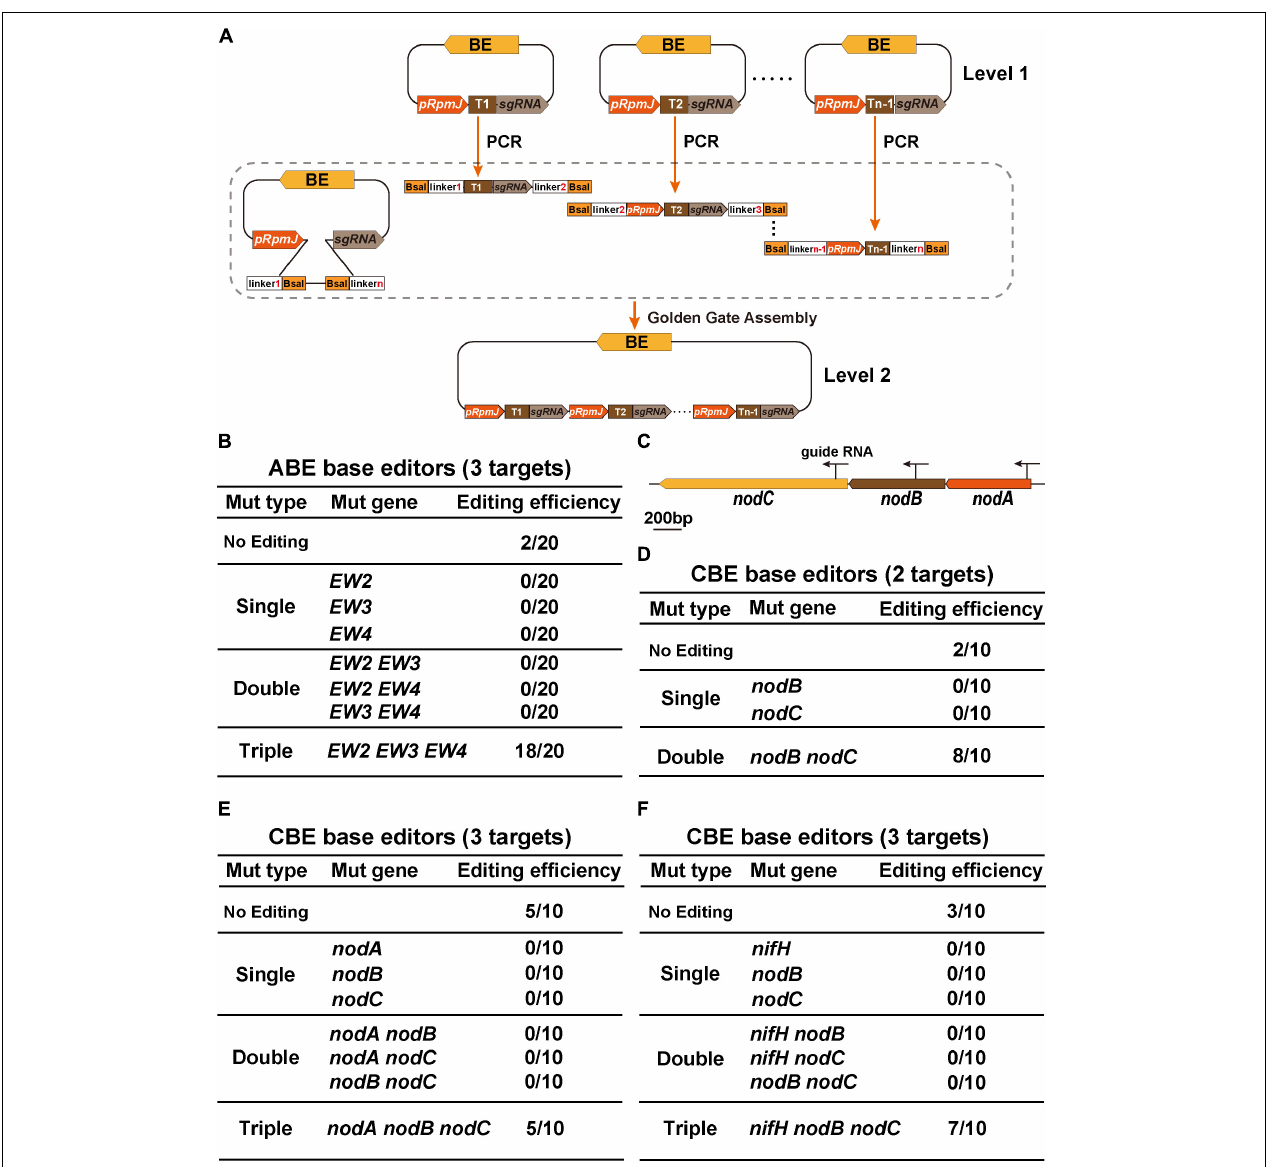
FIGURE 4 | GGA-based multiplex gene editing. (A) Schematic flowchart for the construction of multigene base editing vectors. The single sgRNA was first inserted into the Bsa I site of the target plasmid, which served as a Level 1 vector. The primers containing Bsa I enzyme sites and various linkers were designed and used to amplify sgRNA cassettes from Level 1 plasmids. The first target 1 (T 1 ) part that was amplified spanned from the guide RNA to the terminator. The last target n-1 (T n - 1 ) that was amplified spanned from the pRpmJ promoter to the guide RNA. Other parts were amplified from the integrated cassettes. The final plasmids were constructed using the Golden Gate Assembly method. (B) Editing efficiency assay for target gene conversion using the ABE system. EW2 , EW3, and EW4 represent three rhizobial genes SMc00499 , SMc04218, and SMb21346 , respectively. In total, 20 individual colonies were randomly selected for PCR and Sanger sequencing. (C) Schematic diagram illustrating the genome structure of the nodA , nodB , and nodC genes. The arrows indicate three sgRNA locations in the genome. (D) Editing efficiency assay of nodB and nodC mutations using the CBE system. (E,F) Editing efficiency assay for multigene mutations using the CBE